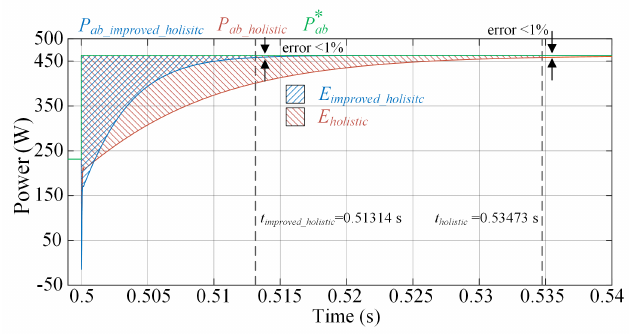
Figure 11. Load transient in GCI going from 231.4 W to 462.8 W.